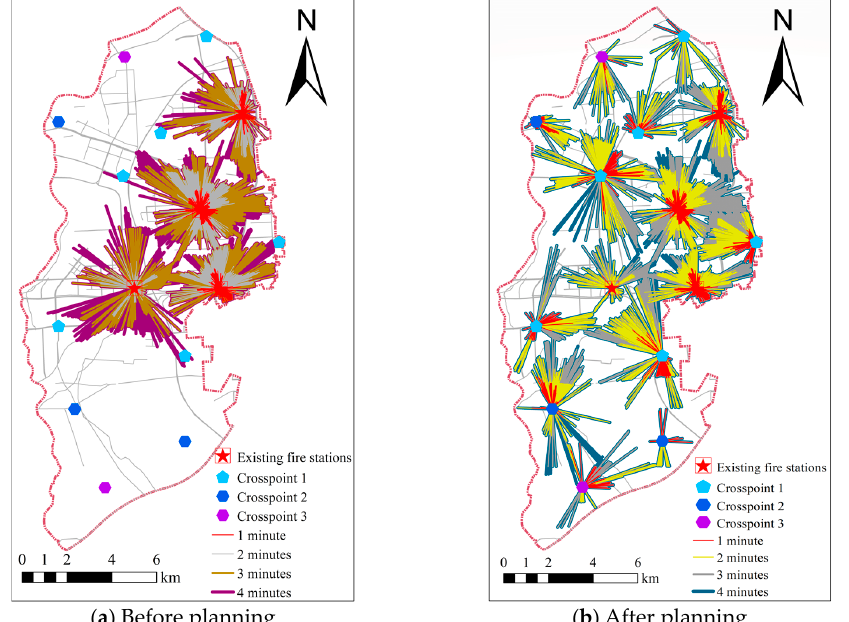
Figure 10. POI coverage in different time periods.